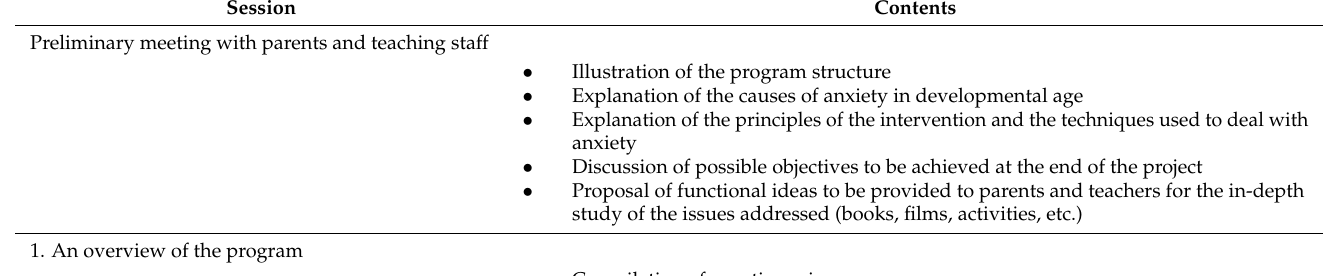
Table 1. Intervention program